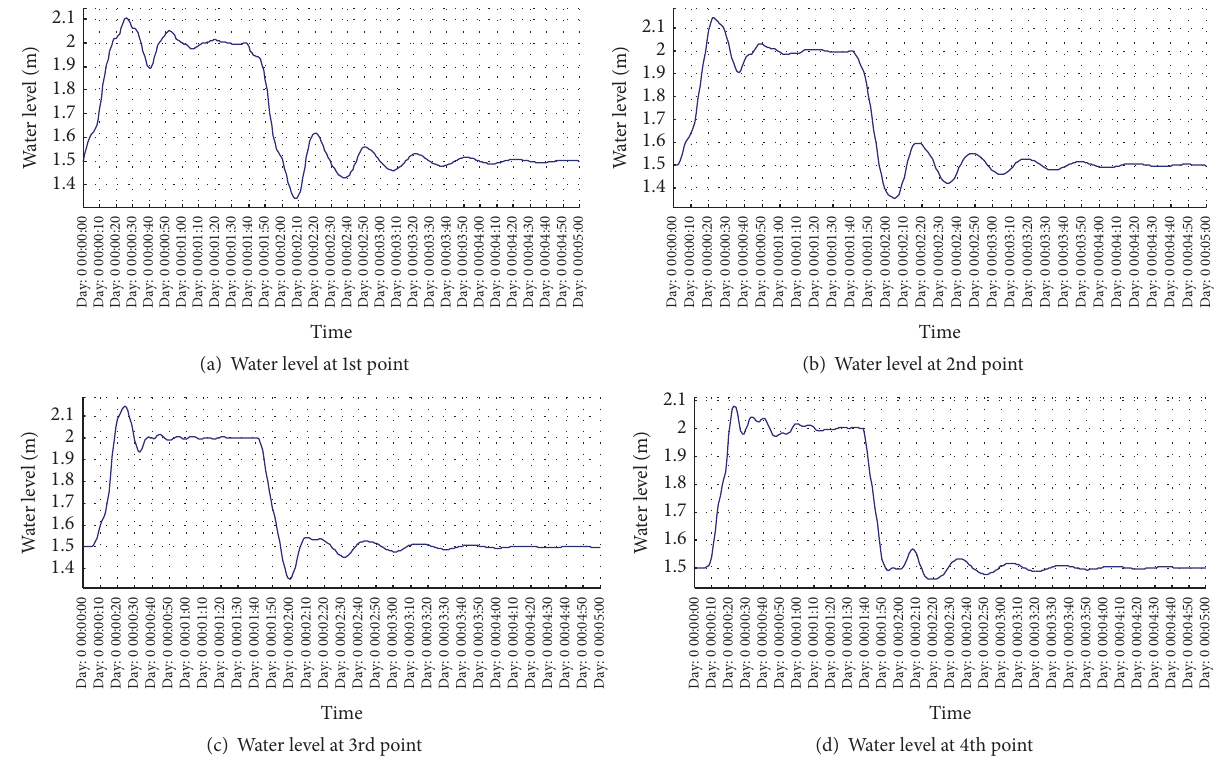
Figure 9: Evolutions of water levels at four points in pool 2 with 𝑁 = 𝑀 = 10 .